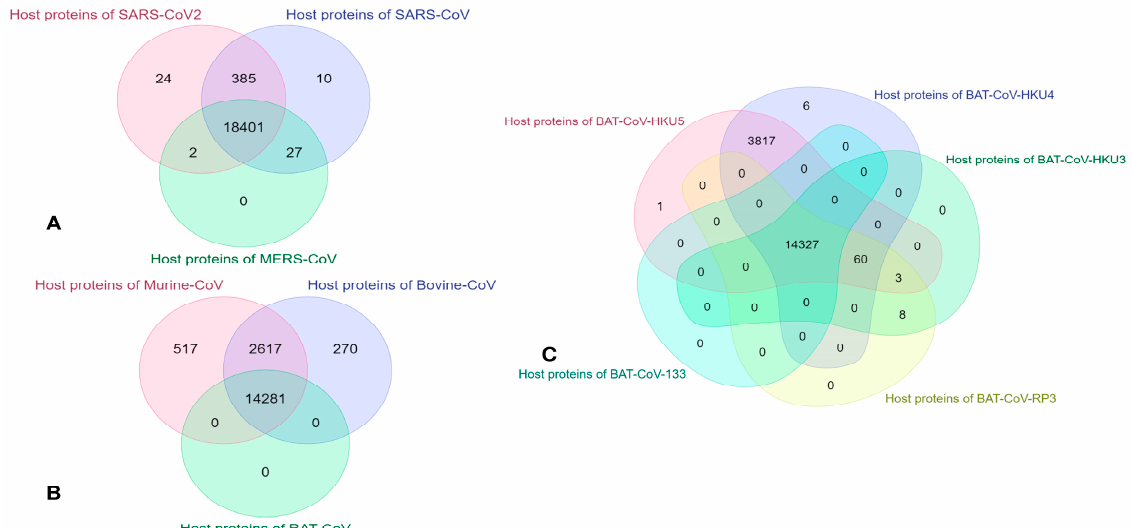
Figure 2. Venn diagram of the number of vulnerable host proteins obtained from host–pathogen interaction for all selected coronavirus organisms at 0.1 fuzzy threshold value. ( A ). The intersection of host protein identified from SARS-CoV-2, SARS-CoV, and MER-CoV. ( B ). Intersected host pro- teins from Murine-CoV, Bovine-CoV, and Rat Coronavirus. ( C ). Intersected host proteins of differ- ent viral organisms of Bat Coronavirus.